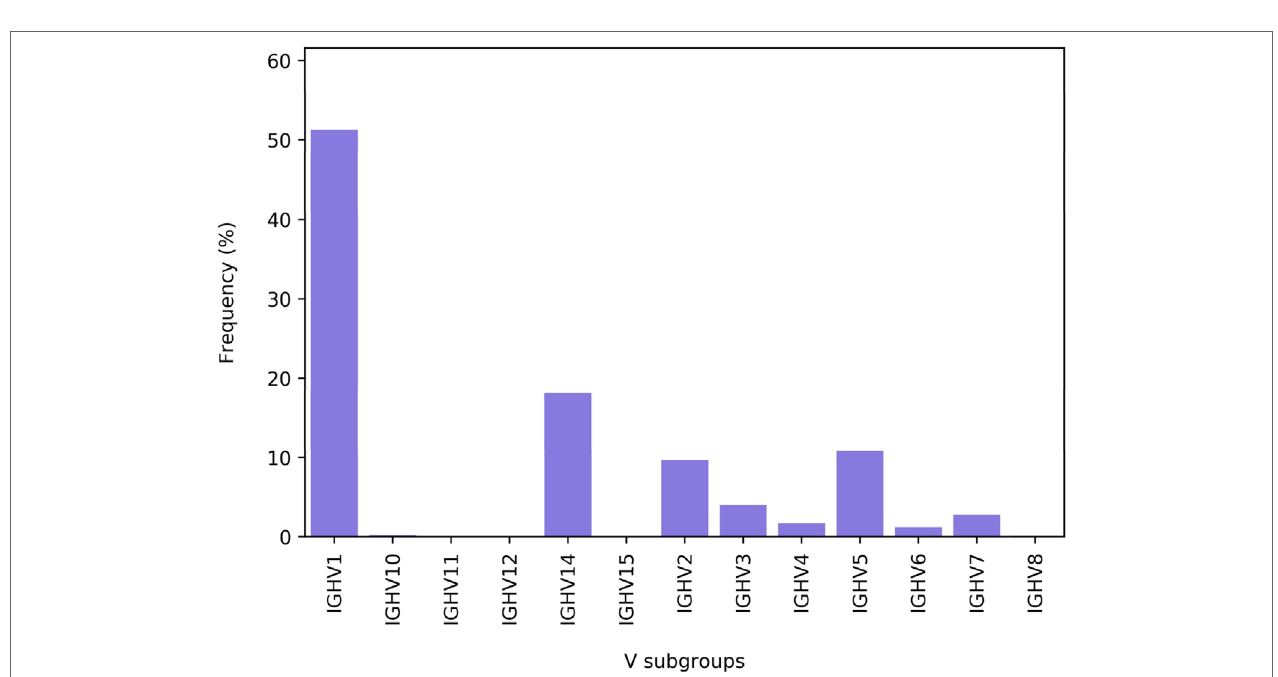
FIguRe 6 | The distribution of V subgroups in a replicate. Shown is the distribution of the subgroup families for the heavy chain of IgG.